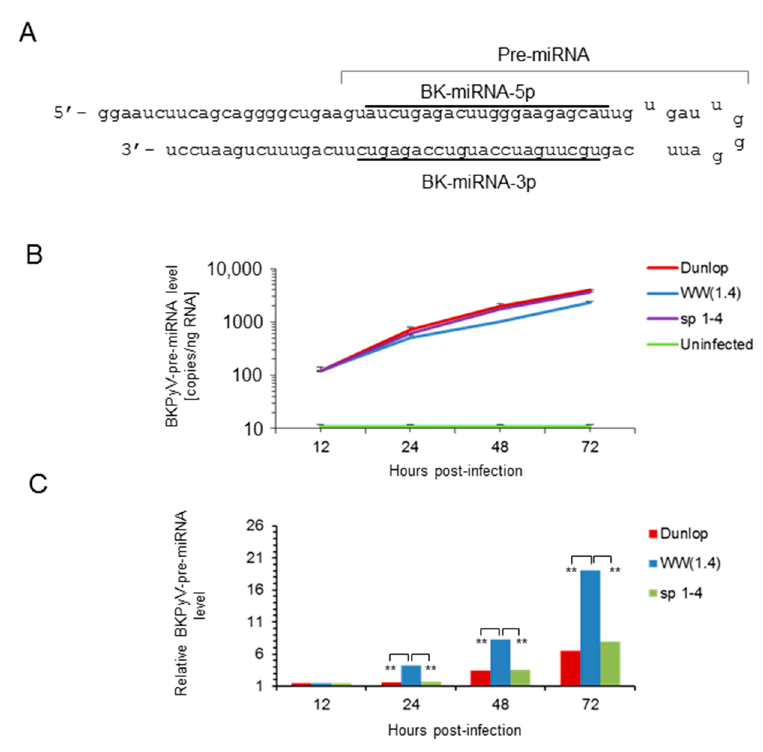
Figure 5. Time course of BKPyV pre-miRNA expression in infected RPTECs. ( A ) Schematic representation of the BKPyV pre-miRNA hairpin and the corresponding BKPyV-miRNA-5p and miRNA-3p sequence (underlined). ( B ) Time course of BKPyV pre-miRNA expression levels after infection of RPTECs with the indicated strains. Mean values ± standard deviation of 3 independent experiments are shown. ( C ) Comparison of relative BKPyV pre-miRNA expression levels per BKPyV genome copy (template) in cells. Results are expressed as BKPyV -miRNA levels normalized to BKPyV genome copy number, archetype WW ( 1.4 ) values at 12 h post-infection are set to 1 (-fold; ** p < 0.01).